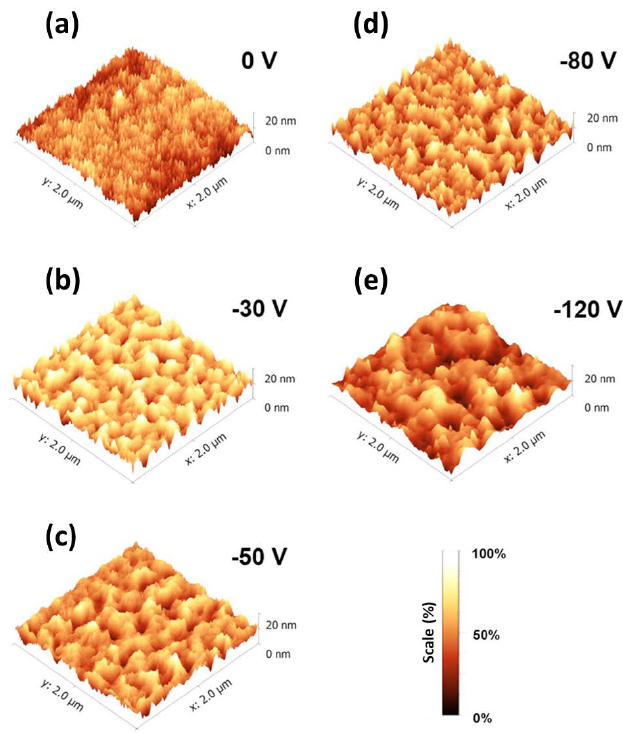
Figure 5. AFM analyses of the Ta coatings deposited by DOMS with a substrate biasing of: ( a ) 0 V;